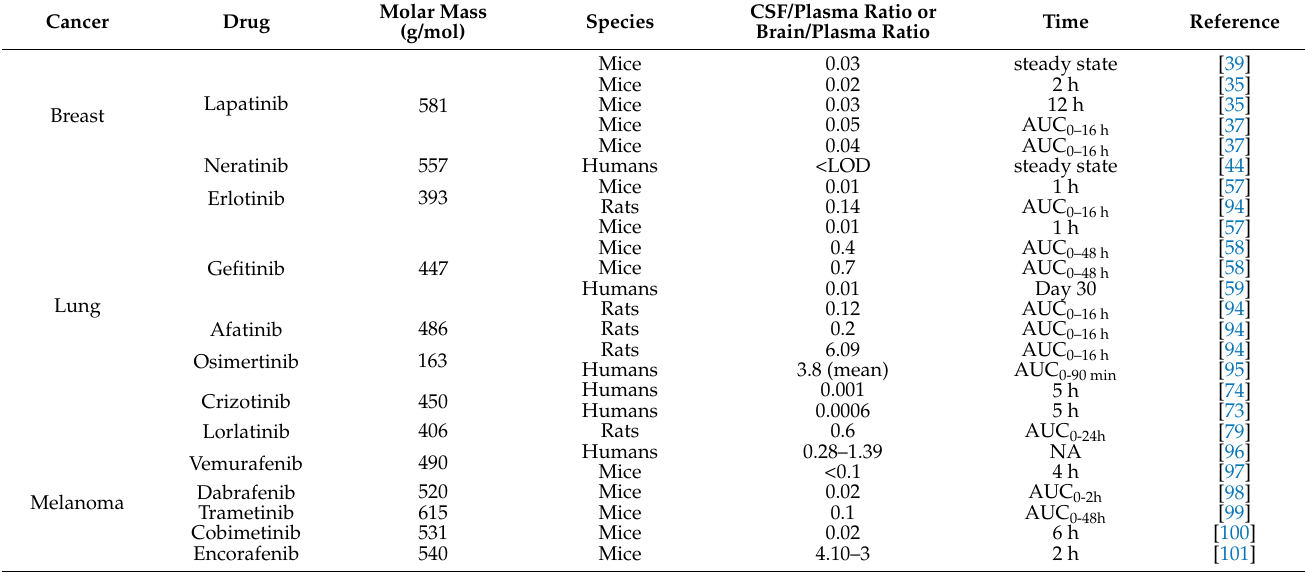
Table 2. Clinical and preclinical pharmacokinetic brain data for different